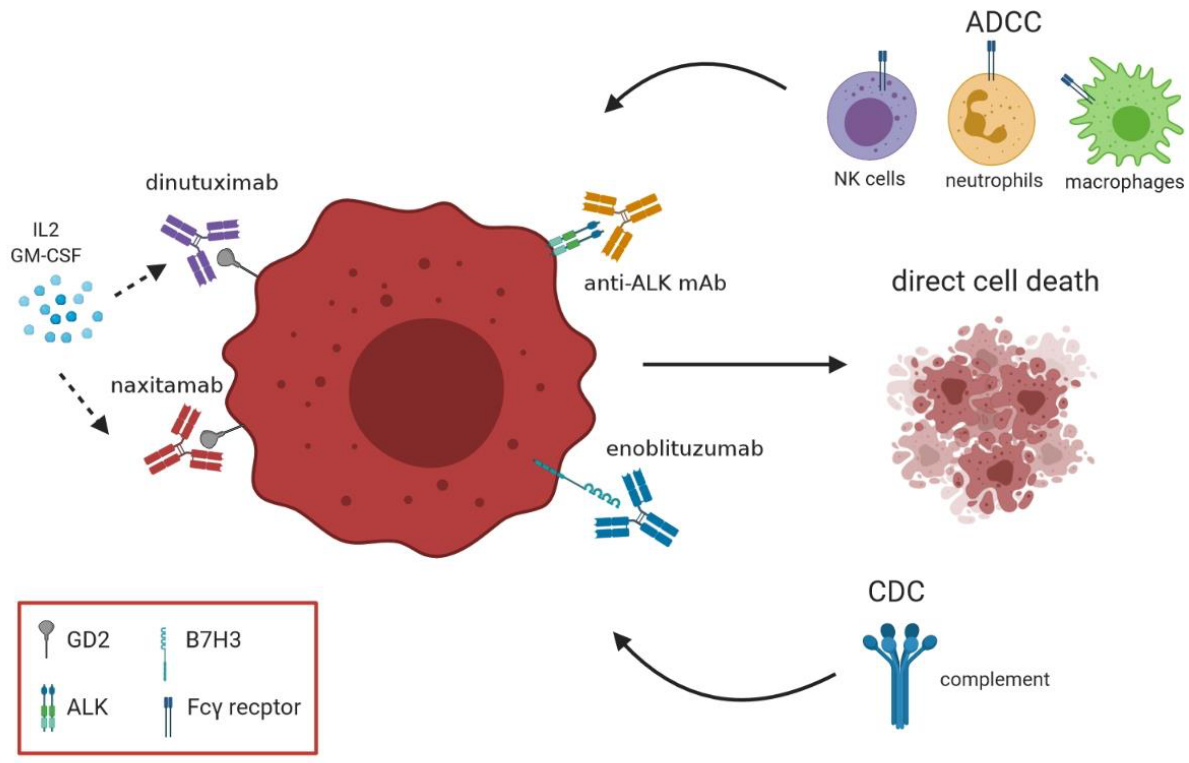
Figure 1. NB immunotherapy based on antibodies and mechanisms of action. The figure describes mechanisms of action of antibodies currently used in clinical settings. These antibodies specific for NB-associated antigens may induce direct cell death, complement-dependent cytotoxicity (CDC) and antibody-dependent cell-mediated cytotoxicity (ADCC). In addition, cytokines such as IL-2 and GM-CSF may increase the anti-tumor activity exerted by these antibodies. Table 2. Clinical trials using granulocyte-macrophage colony stimulating factor (GM-CSF) and anti-GD2 in the last ten years.